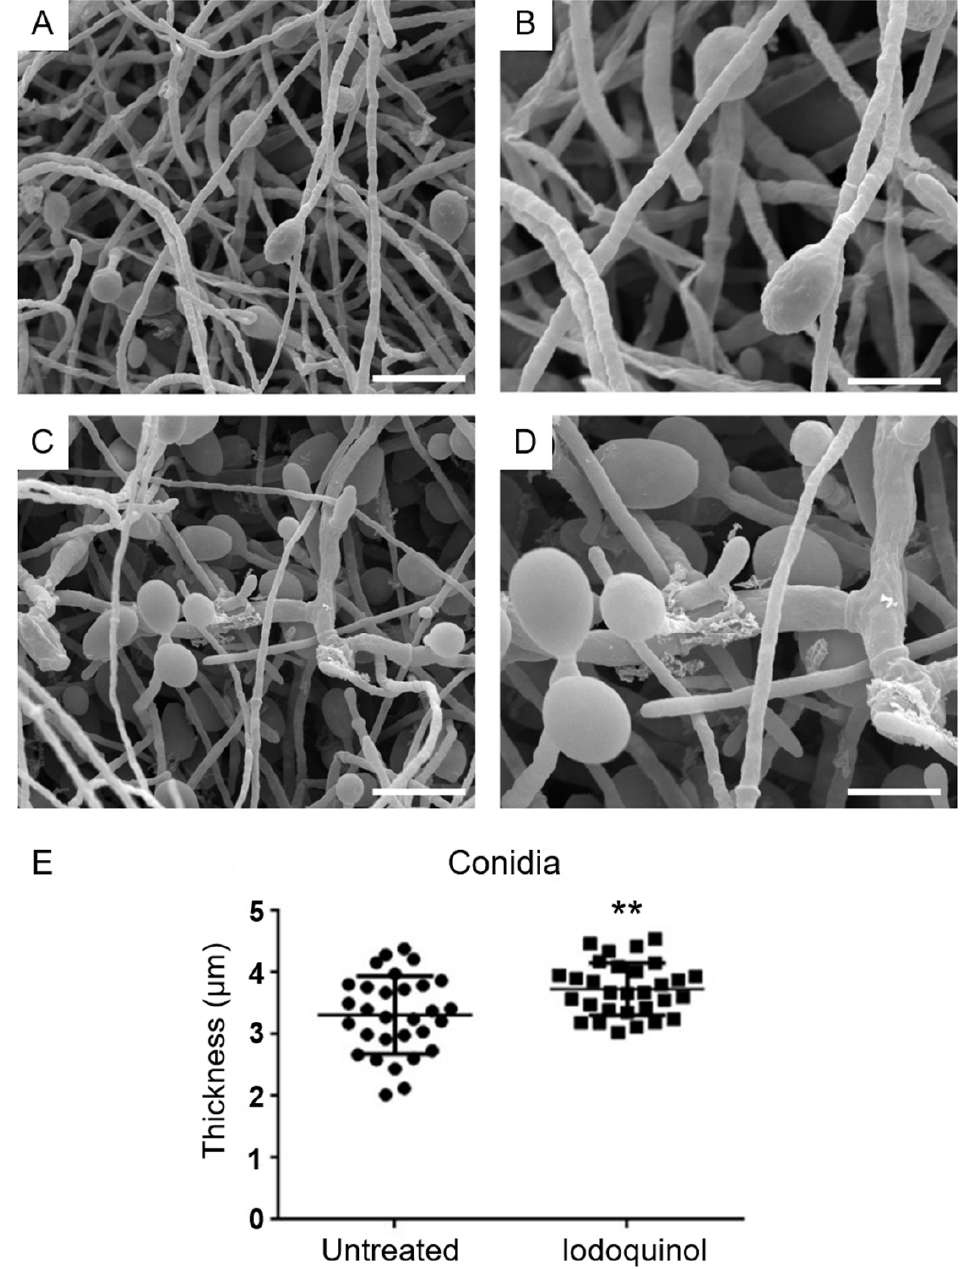
Figure 6. S. aurantiacum CBS 136046 alterations after treatment with iodoquinol, evaluated by scanning electron microscopy. Untreated cells exhibit sympodial conidia with ellipsoidal shape ( A , B ), while samples treated with 1.25 µ m iodoquinol for 48 h show disruption of the cell wall ( C , D ) and increase in conidia thickness ( E ). Bars: 25 μ m ( A , C ) e 5 μ m ( B , D ). ** p < 0.01.